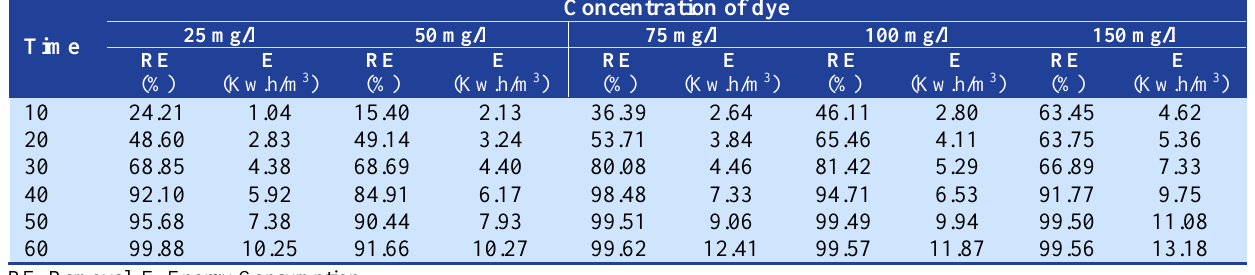
Concentration of